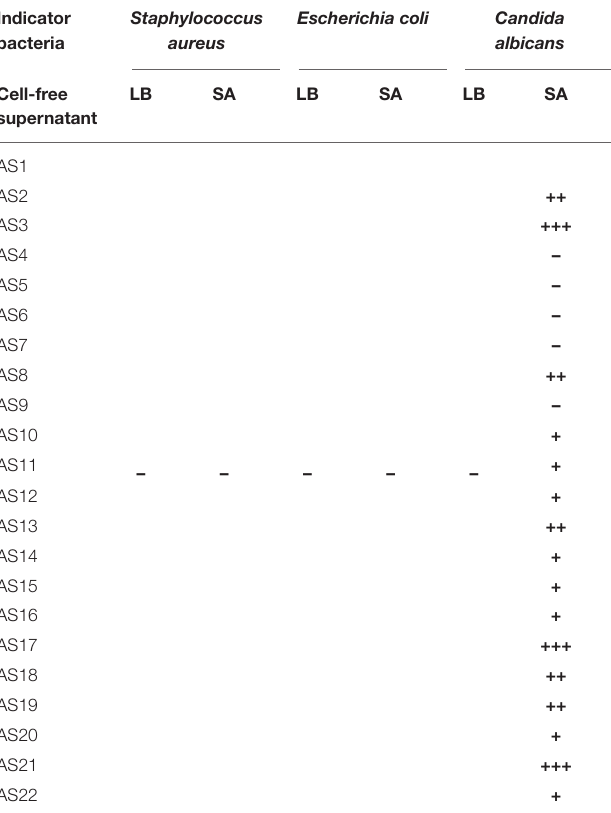
TABLE 1 | In vitro antimicrobial activity of cell-free supernatant (CFS) of bacterial strains. Indicator